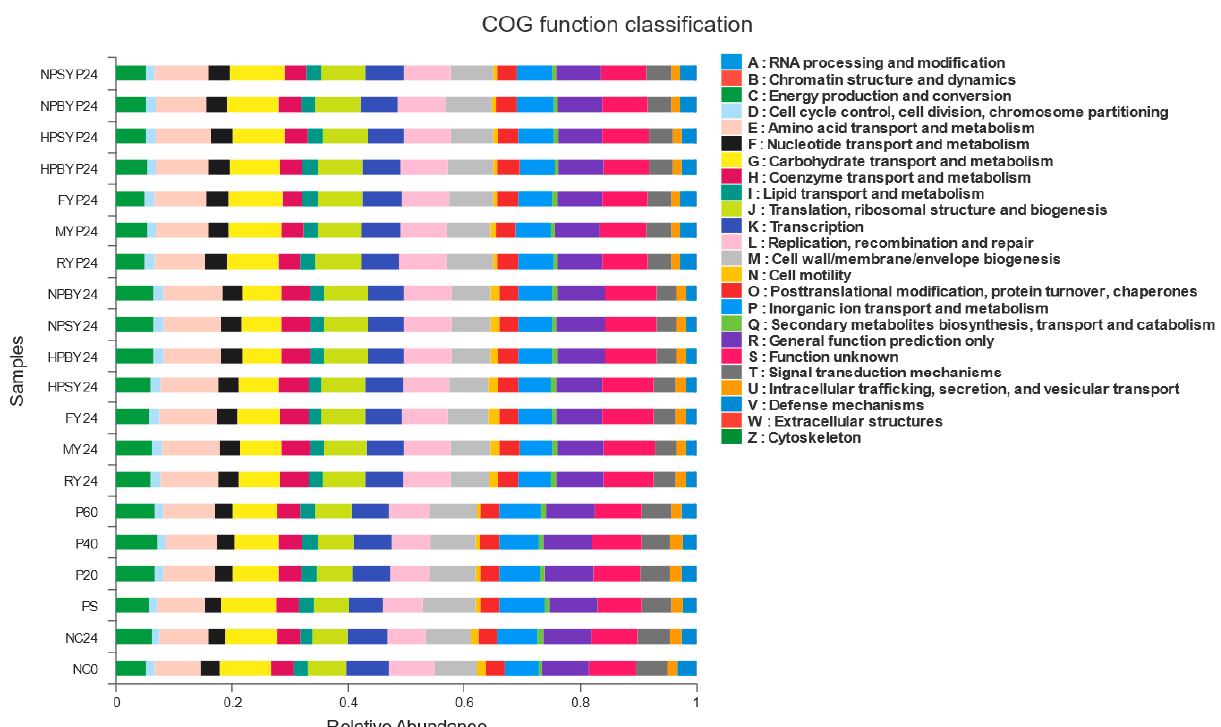
Figure 3. Histogram of COG function classification statistics. Note: 0 h fermentation broth, 24 h fermentation broth. NC = blank, NPSY = Normal-pressure steamed yam, NPBY = Normal-pressure boiled yam, HPSY = High-pressure steamed yam, HPBY = High-pressure boiled yam, MY = Mi- crowaved yam, FY = Stir-fried yam. RY = Raw yam. NPSYP = Normal-pressure steamed yam polysaccharide, NPBYP = Normal-pressure boiled yam polysaccharide, HPSYP = High-pressure steamed yam polysaccharide, HPBYP = High-pressure boiled yam polysaccharide, MYP = Mi- crowaved yam polysaccharide, FYP = Stir-fried yam polysaccharide RYP = Raw yam polysaccharide. PS: glucan standard (The molecular weight: 80 KD); P20: The molecular weight: 20 KD; P40: The molecular weight: 40 KD; P60: The molecular weight: 60